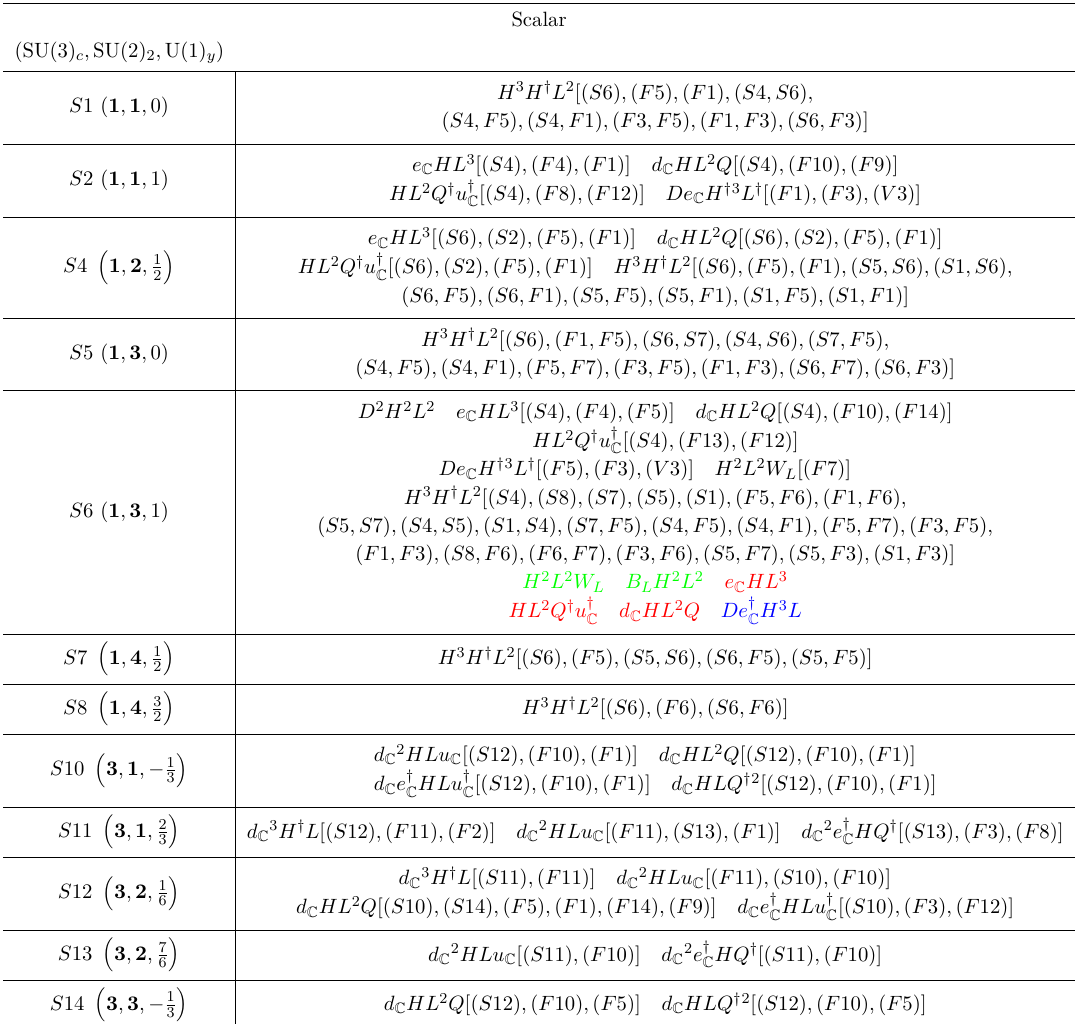
Table 18 . Scalar resonances which could generate the dim-7 operators. The name of the resonances is organized by the gauge quantum number. The resonance appeared in the squared bracket of the operator indicate that both resonances are needed to generate such